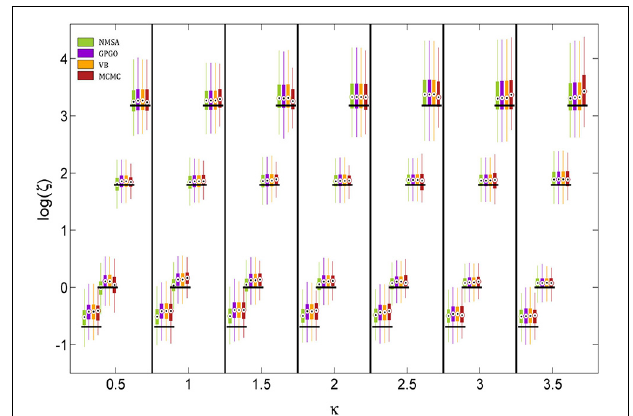
FIGURE 8 | Estimation of noise level ζ at different levels of coupling κ . ζ is estimated and displayed here at the logarithmic scale because it has a natural lower bound at 0. See Figure 7 for key to legend. The figure shows boxplots of the distributions of the maximum-a-posteriori (MAP) point estimates for the four methods at each point of the simulation grid. Horizontal shifts within κ levels are for readability. Black bars indicate ground